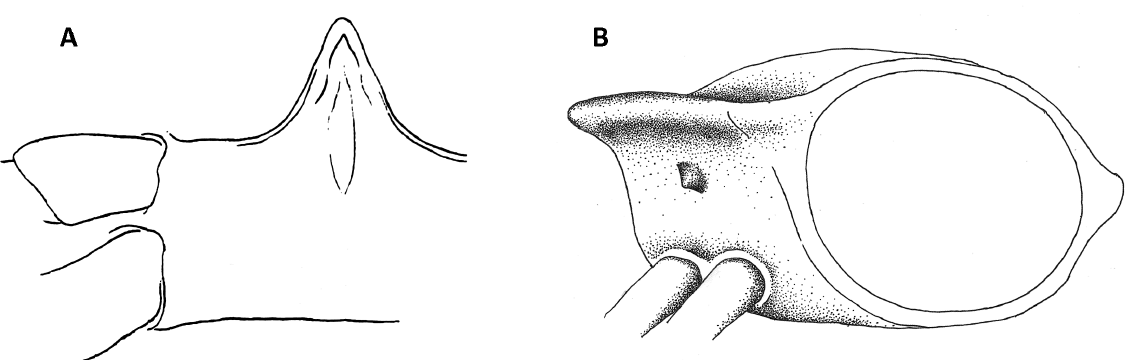
Fig. 4. Particular gomphodesmid structural elements. A . Paxillus – a mid-ventral, most often triangular process on body ring 15 in most gomphodesmid males, from Hoffman (2005), modified. B . Torus – a low convexity of variable size and shape, found on the ventral surface of the poriferous paranota in males of many gomphodesmid species. Not drawn to